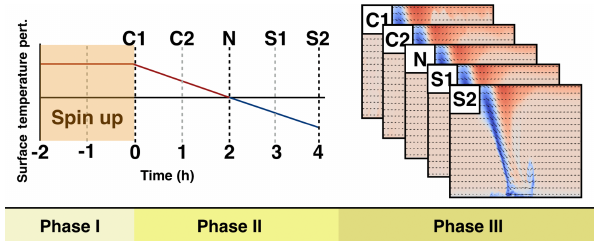
Figure 2. A schematic diagram depicting the process for simulating downbursts throughout the evening transition period. The first phase consists of model spin-up to generate the CBL. The second phase simulates the ET while outputting a snapshot every hour to be used as the initial and boundary conditions in the downburst simulations performed in Phase III. These snapshots are denoted as C1 for the moderately convective case, C2 for the weakly convective case, N for the neutral case, S1 for the weakly stable case, and S2 for the moderately stable